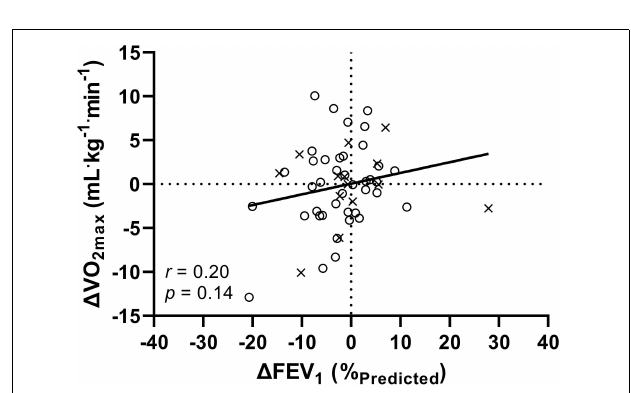
FIGURE 3 | The relationship between the annual change ( (cid:49) ) in FEV 1 and VO 2max for 54 patients with CF. Crosses ( × ) indicate combined IGT/CFRD group, circles ( ◦ ) indicate NGT group. FEV 1 : forced expiratory volume in 1 s; VO 2max : maximal oxygen uptake. All data is presented as T1-T0 (i.e., a negative number indicates a decrease in function over the course of 1